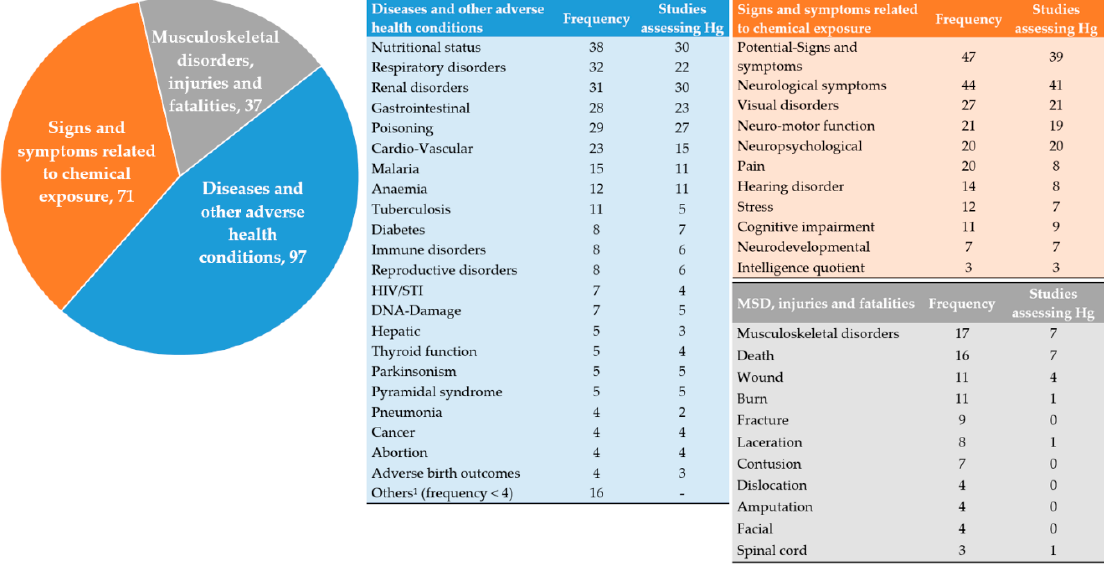
Figure 8. Main and sub-categories of adverse health conditions investigated at both population and individual level in ASM settings. Note: DNA, deoxyribonucleic acid; Hg, mercury, HIV, human immunodeficiency virus; MSD, musculoskeletal disorders; and STIs, sexually transmitted infections. Other adverse health outcomes are reported in less than four studies, each.